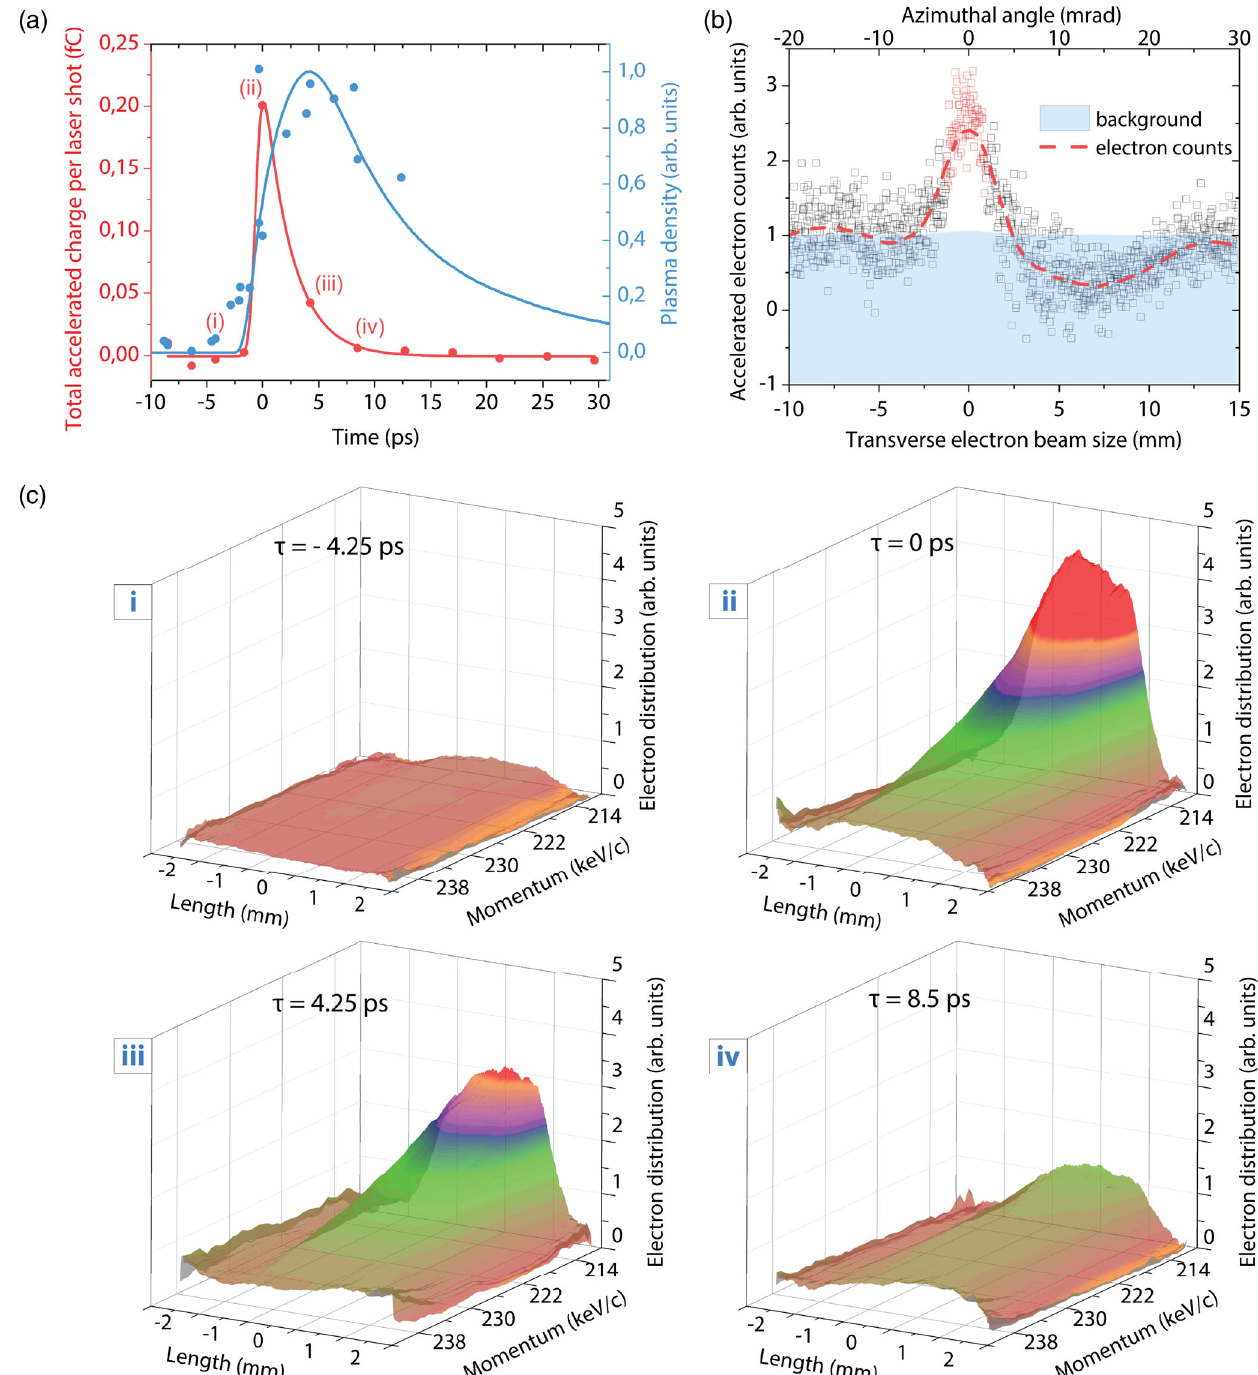
FIG. 2. Laser-electron interaction. (a) Electron-laser beam coincidence timing (blue) and normalized charge of detected accelerated electrons (red) as a function of laser-electron timing delay ( τ ). (b) Accelerated electron counts contained in the deflector plane at τ ¼ 0 . (c) Snapshots of the normalized distribution in real and momentum space of accelerated electrons at four different temporal overlaps: (i) there are no accelerated electrons when the initial electron bunch arrives at the IP 8.5 ps before the laser; (ii) distribution at the peak of total accelerated charge ( τ ¼ 0 ) them beam is delayed by (iii) 4.25 ps and (iv) 8.5 ps with respect to the laser